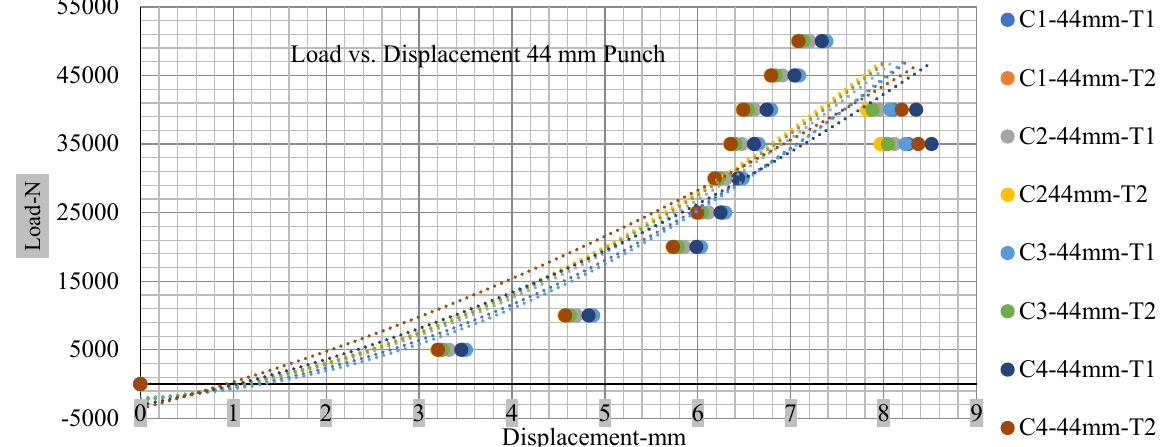
Figure 17. Load vs. displacement 44 mm low to peak loads.